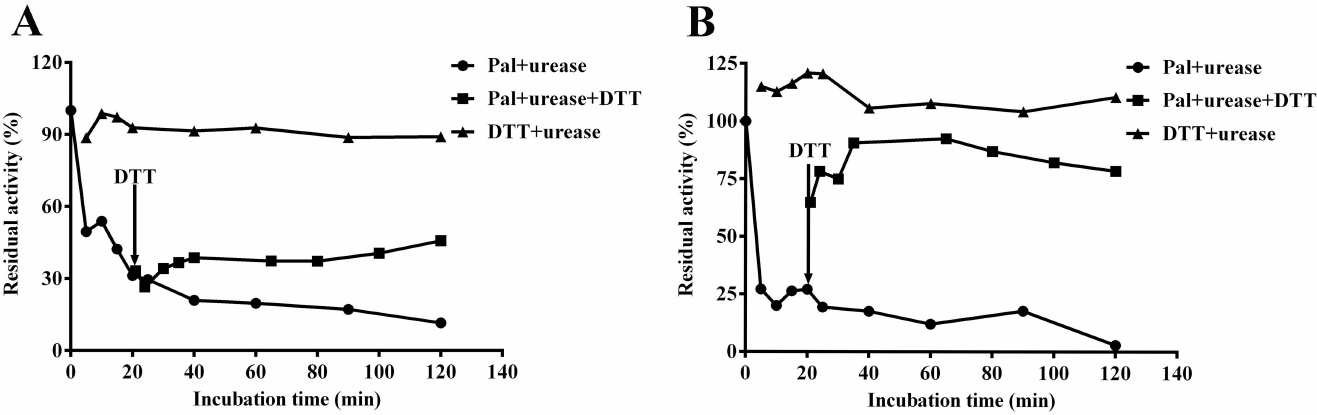
Fig 6. Reversal of Pal-inhibited HPU (A) and JBU (B) activity by DTT. The urease enzymatic activity was inhibitedby Pal (•), and DTT ( ▪ ) was added post 20 min. In the assay system, 1.25 mM DTT and 0.5 mM Pal were used for both ureases(0.25 mg/mL). Activity of Pal-inhibitedureasewas monitored before and after DTT addition,1.25 mM DTT without was used as a control. Results summarized here are the mean value of n = 3 ±